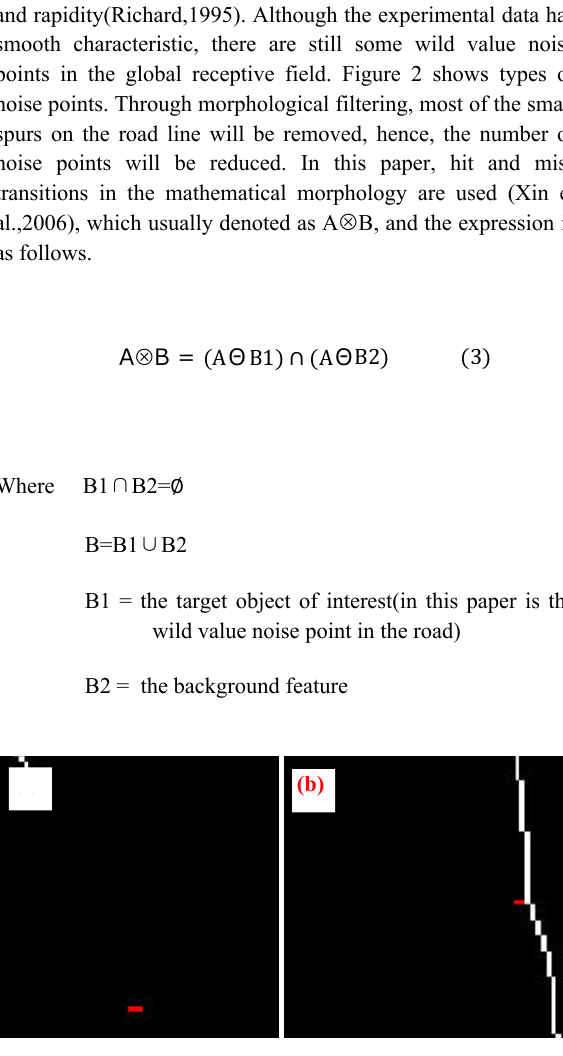
Figure 2. Noise point types: (a) discrete noise point, (b) road spike noise